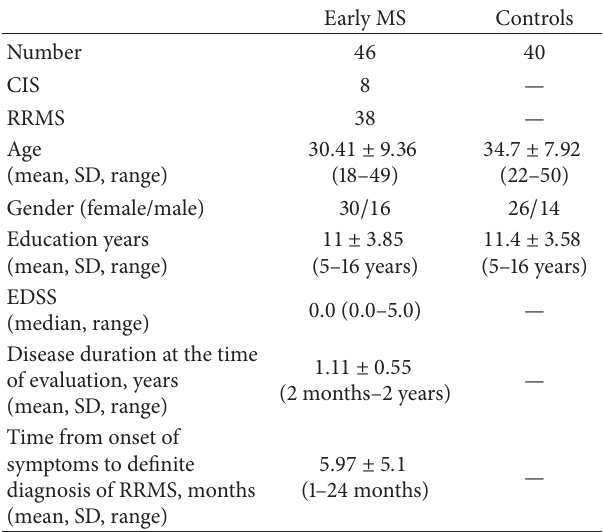
Table 1: Clinical and demographic characteristic of the patients and